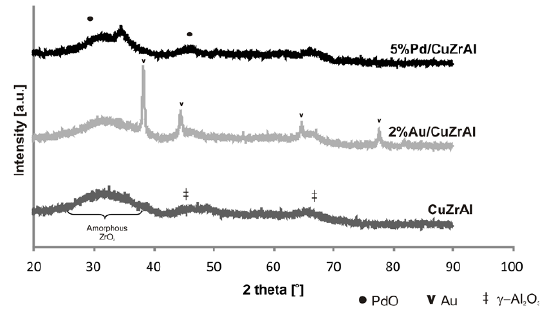
Figure 2. XRD patterns for CuZrAl, 2%Au/CuZrAl, 5%Pd/CuZrAl catalysts calcined in air at 400°C for 3.5